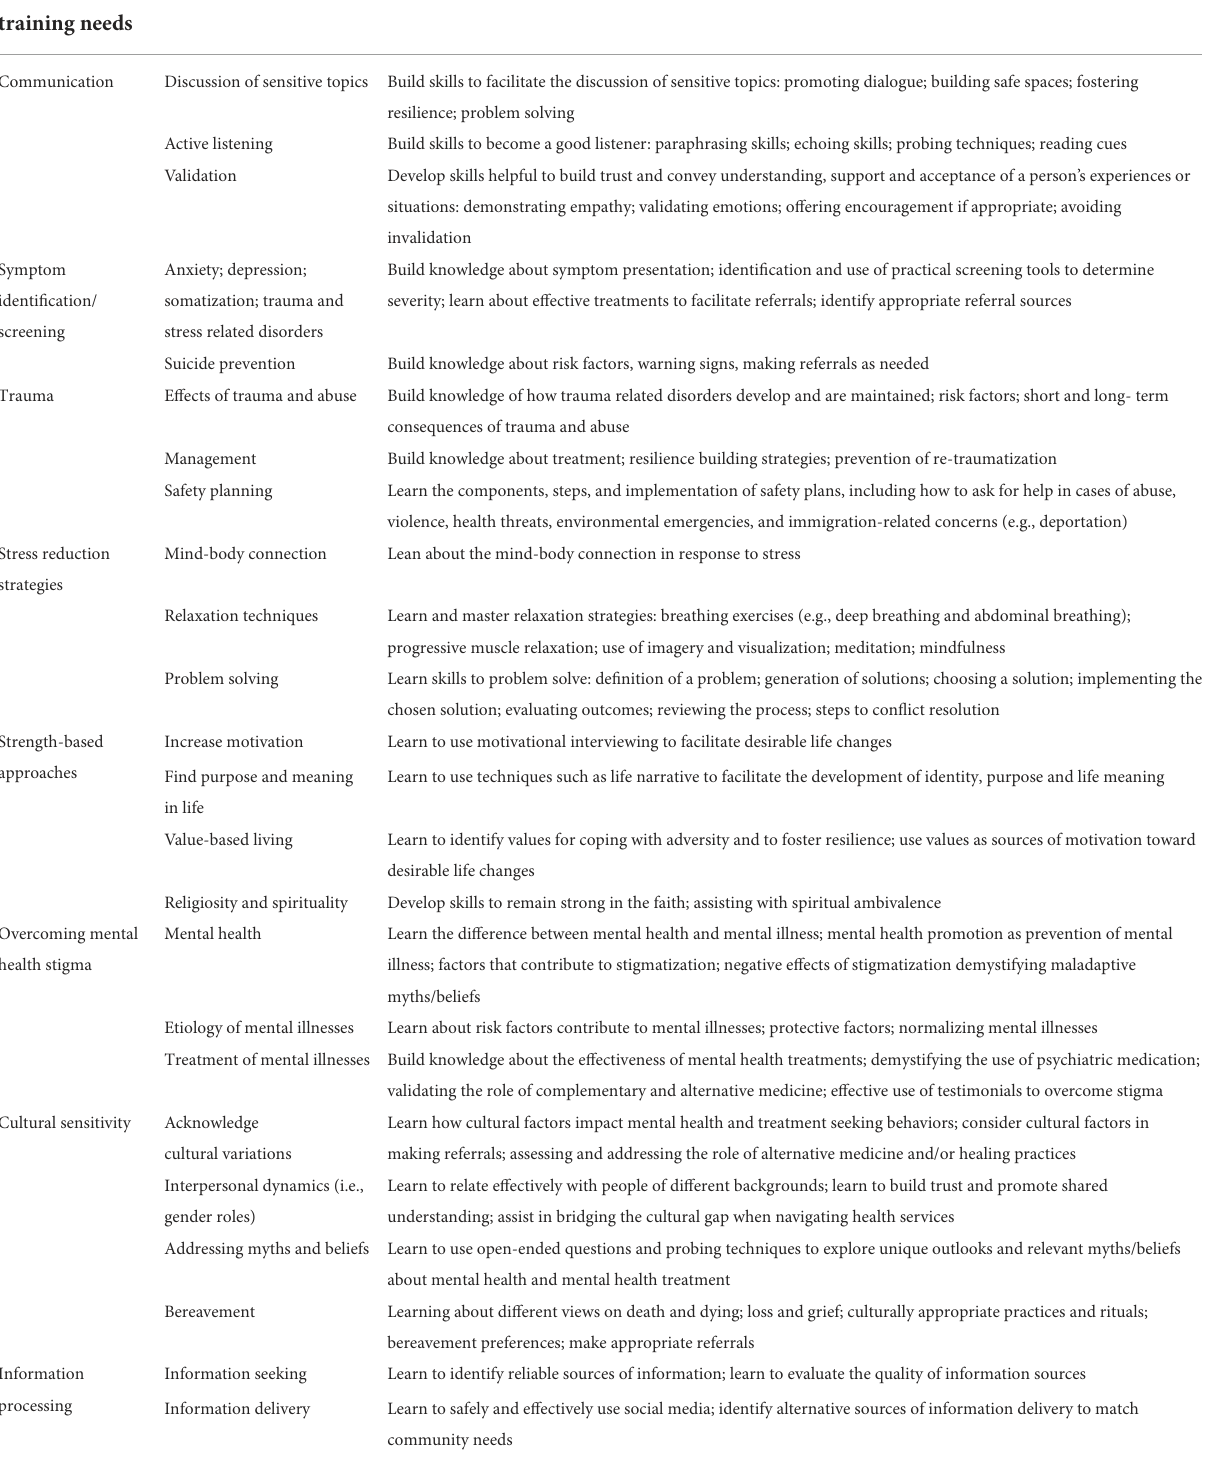
TABLE 4 Recommendations for CHWs’ mental health training needs. Recommended domains